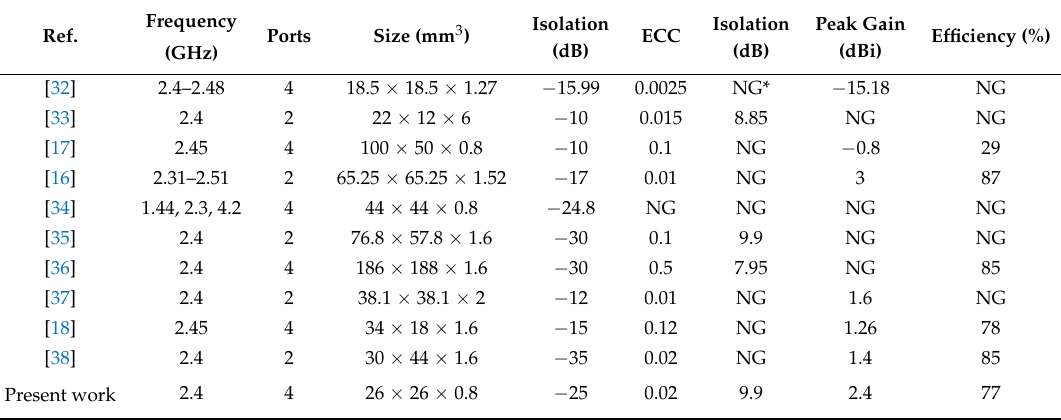
Table 1. Comparison of the performance of the published scientific and medical (ISM) band multiple-input multiple-output (MIMO)